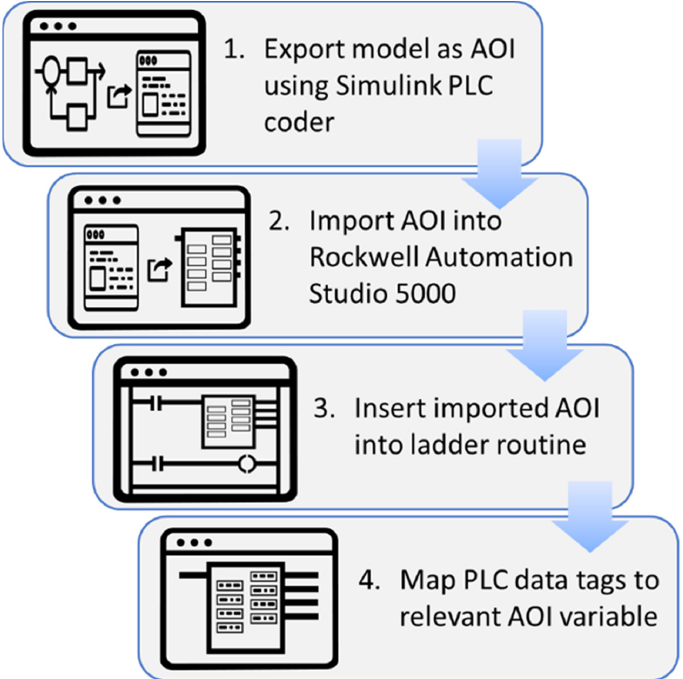
Figure 10. Automatic PLC code generation process.